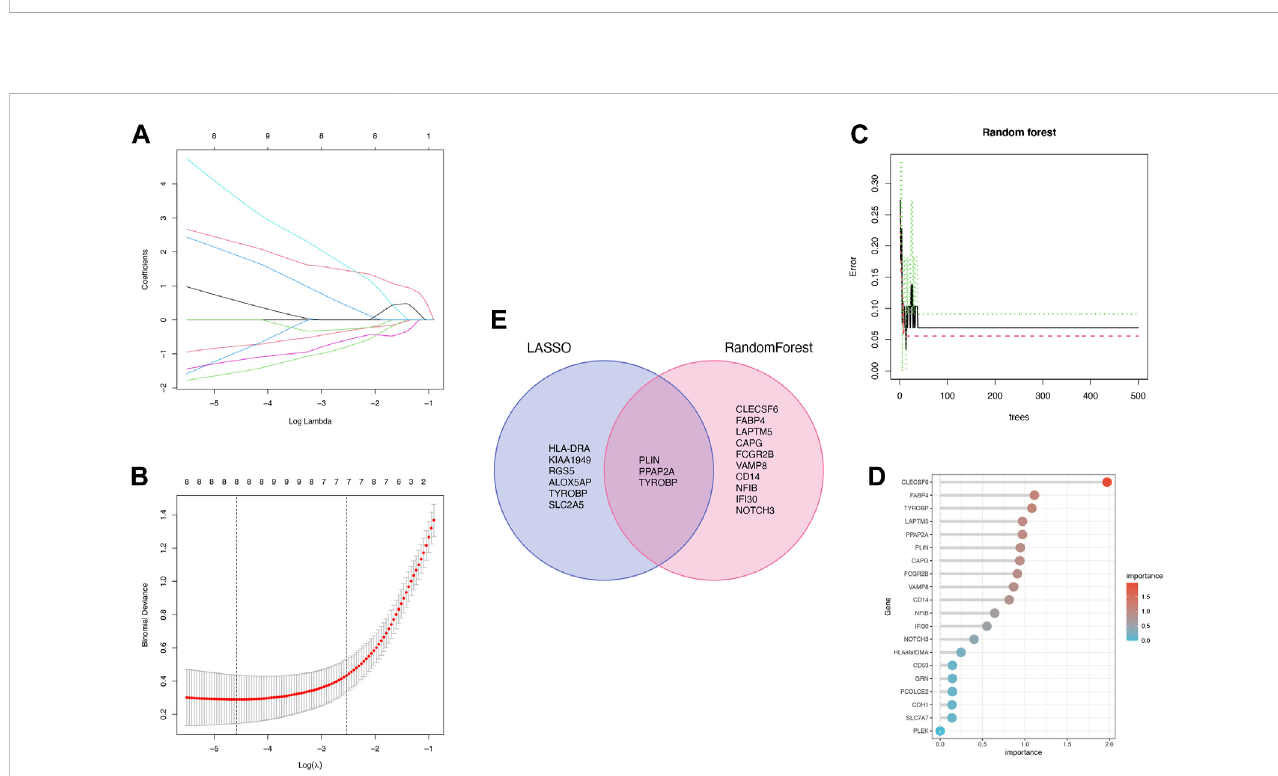
FIGURE 5 (A,B) LASSO logistic regression algorithm is used to retain the most predictive features and tuning parameter selection in the LASSO model (C,D) Identi fi cation of the relative importance via PVNS and RA by calculating RF. (E) Intersection of two machine learning genes to obtain three machine learning.